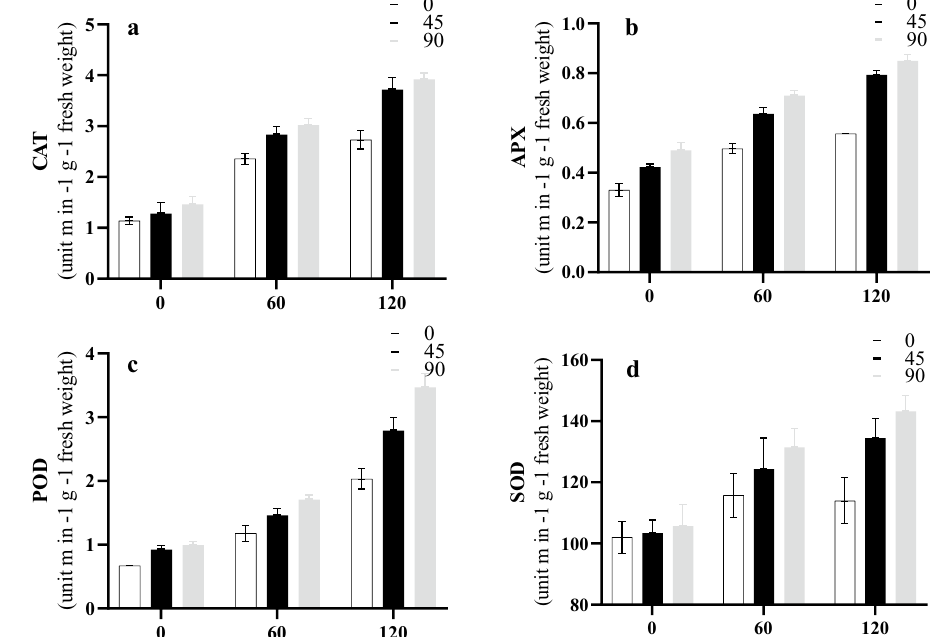
Figure 5. Interactions effects of salinity and NPs on CAT ( a ), APX ( b ), POD ( c ), and SOD ( d ).